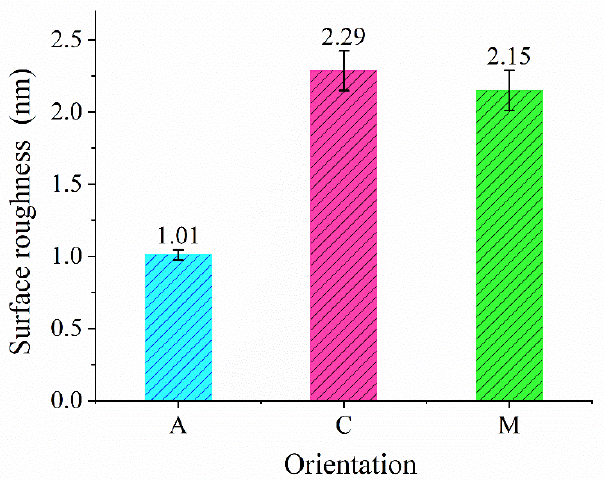
Figure 6. Surface roughness of the bottom of the FIB-etched pits on A-, C-, and M-plane sapphires.